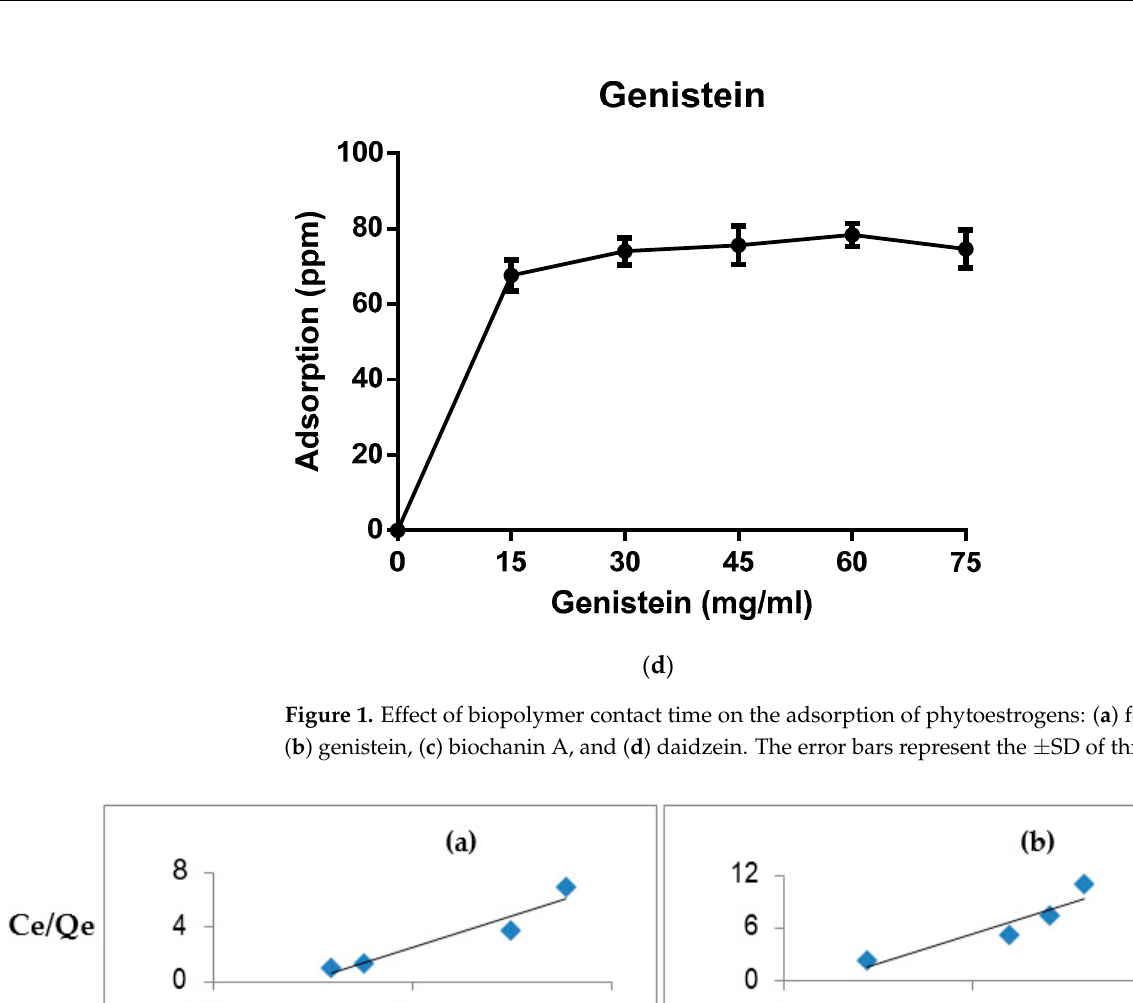
Figure 1. Effect of biopolymer contact time on the adsorption of phytoestrogens: ( a ) formononetin,